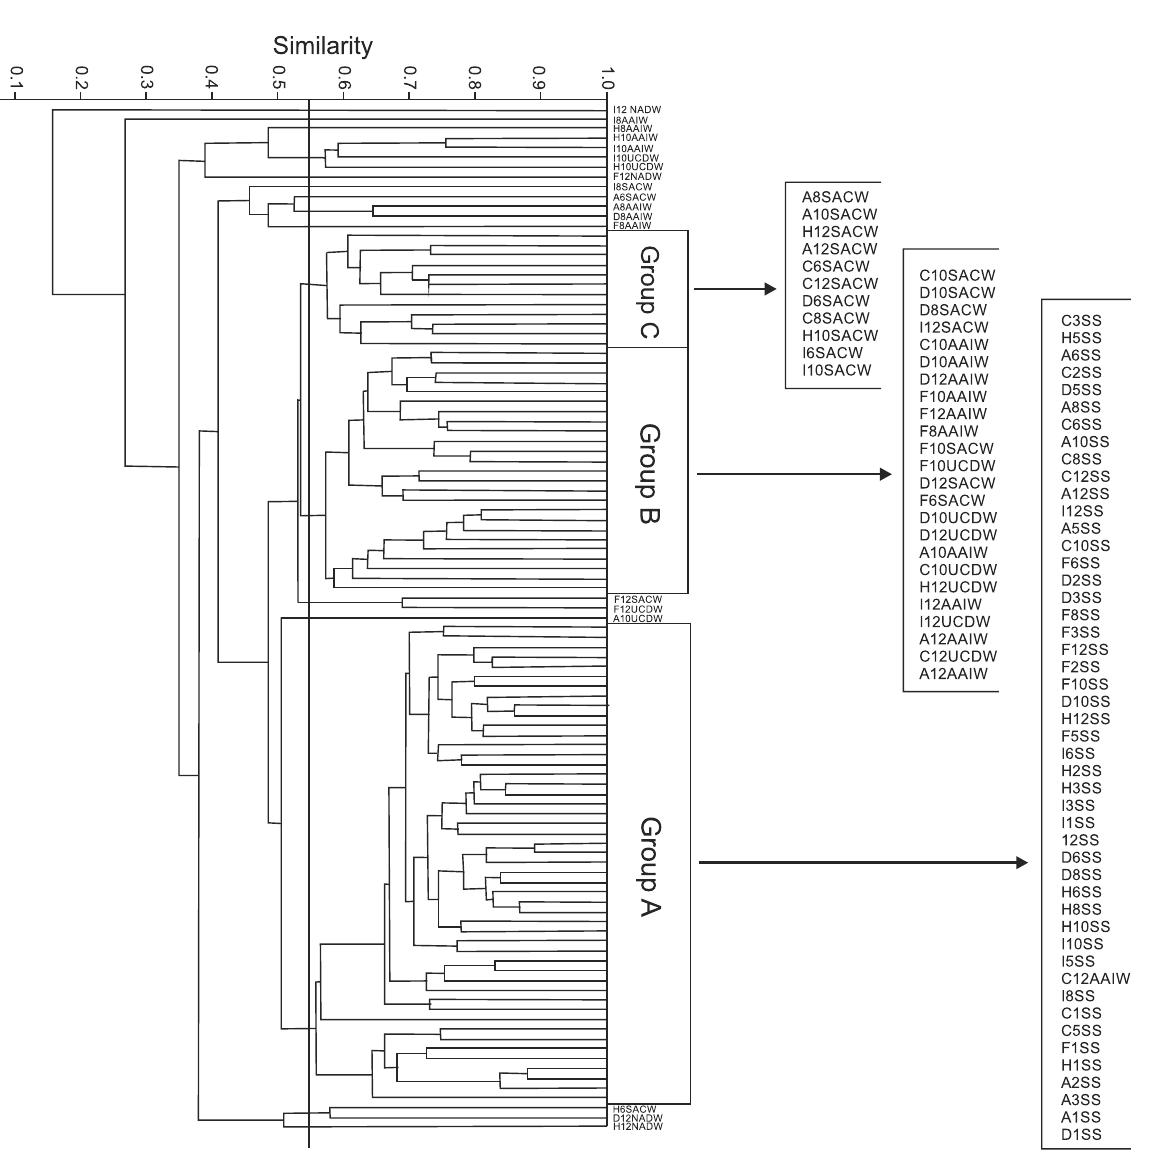
Figure 4. Cluster analysis based on species composition in samples from the water masses in the Campos Basin, central Brazilian coast, during the rainy season. For the analysis, the Sørensen-Dice coefficient with average linkage method was used. Different groups indicate faunistic zones, defined at 55% similarity. In data labels: the first letter indicates transect, number indicates station, and the letters after station number indicate water masses (SS – Subsurface Water, SACW – South Atlantic Central Water, AAIW – Antarctic Intermediate Water, UCDW – Upper Circumpolar Deep Water, NADW – North Atlantic Deep